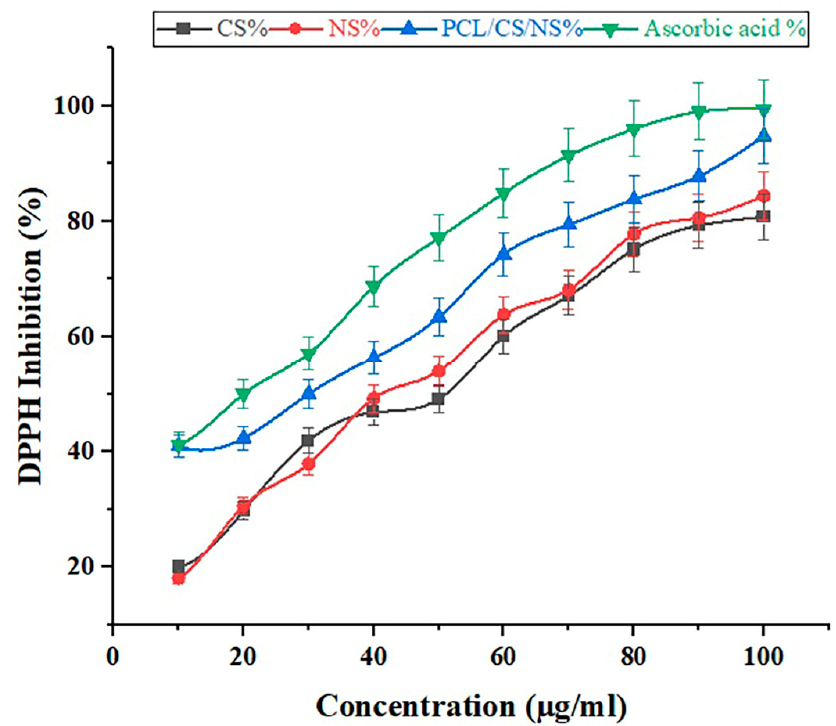
Figure 6. Percentage inhibition of DPPH radical in the presence of different concentrations of CS, NS, PCL/CS/NS nanofiber mats, and ascorbic acid. Table 4. DPPH inhibition (%) of different concentrations of PCL/CS/NS nanofiber mats. Concentration (µg/mL)